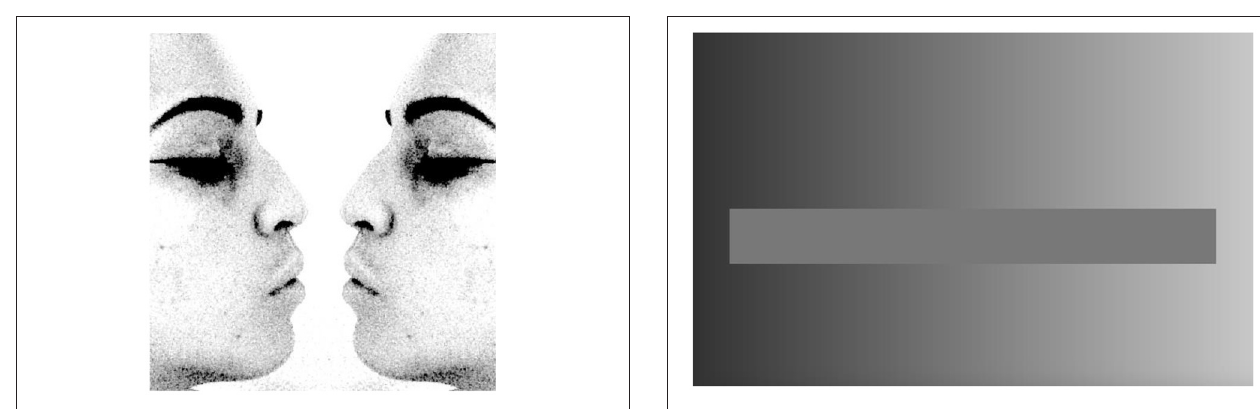
common—particularly with plain Rubin’s vase ( Figure 1